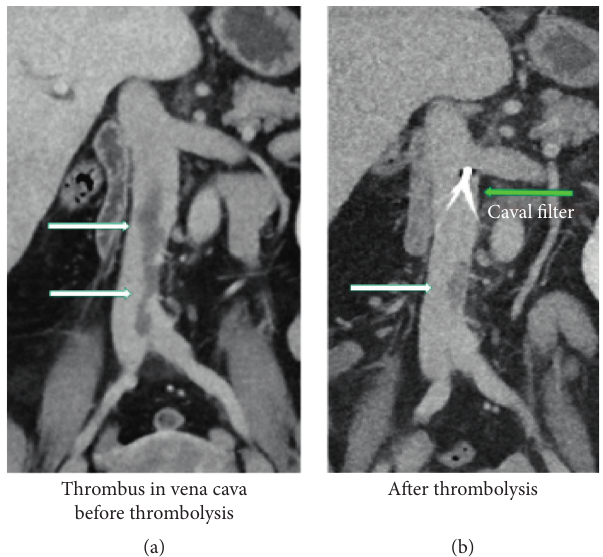
Figure 3: CTPA demonstrating a thrombus of 11 centimetre in the inferior vena cava. (a) The thrombus in the IVC before thrombolysis (white arrows); (b) the residual thrombus (white arrow) following thrombolysis and after insertion of the vena cava filter (green arrow). Abbreviations: CTPA: computed tomography pulmonary angiogram, IVC: inferior vena